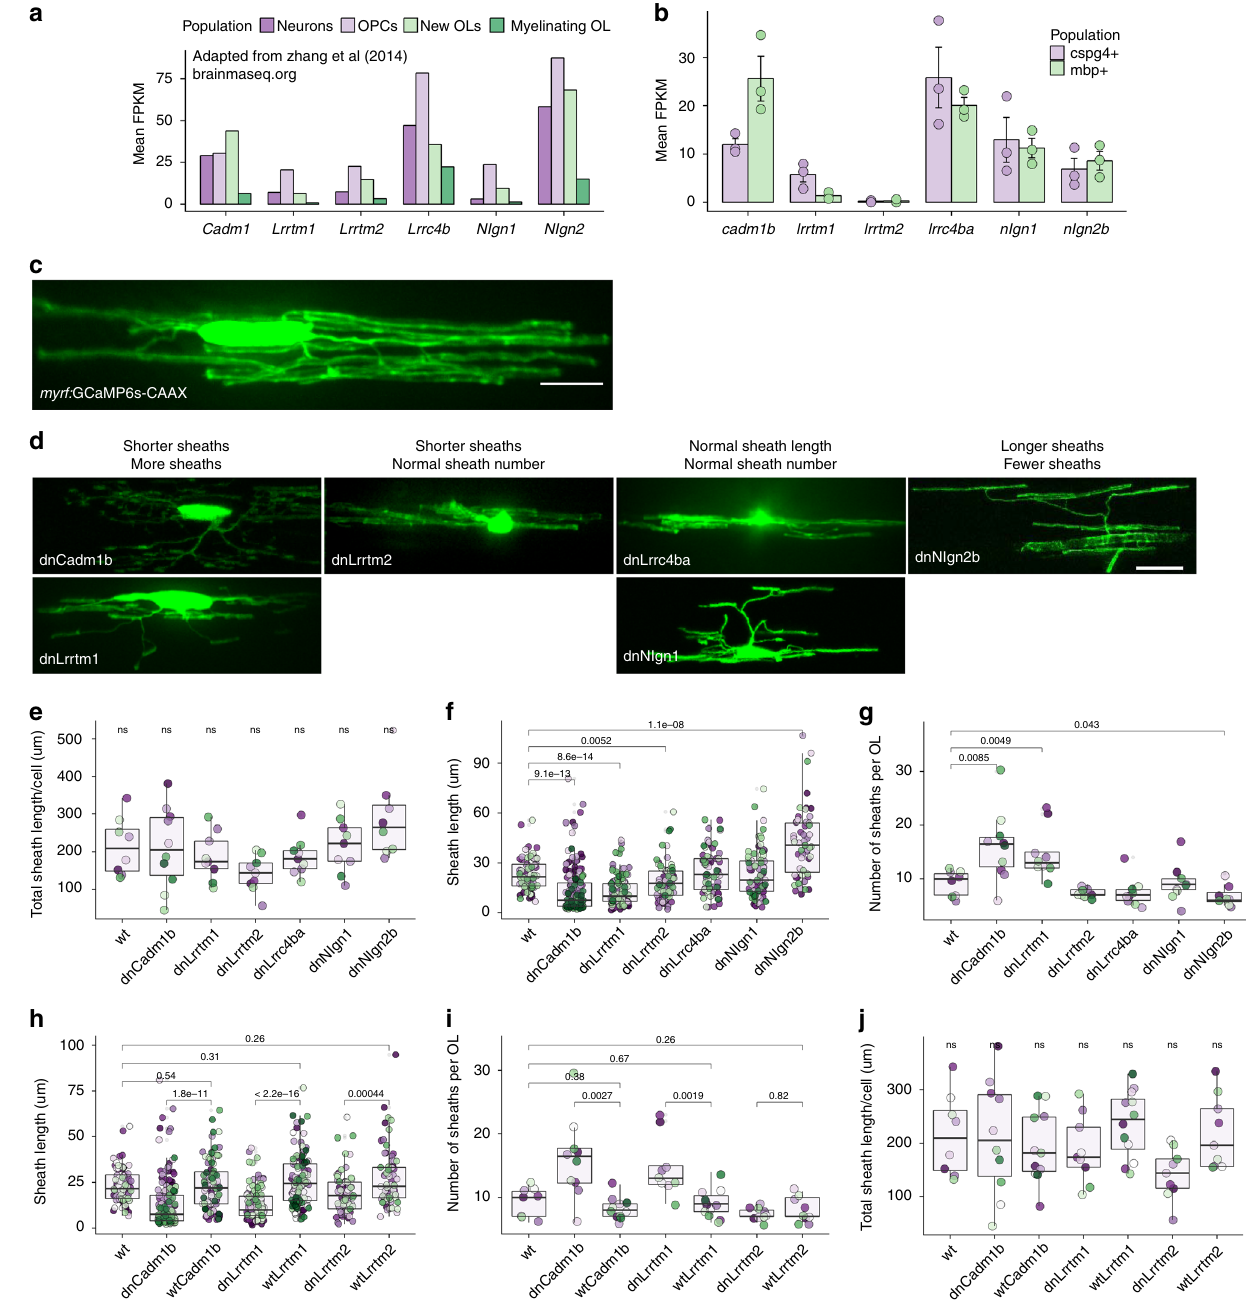
Fig. 4 Candidate synaptogenic adhesion molecules have variable effects on myelin sheath length and number. a RNA-seq FPKM values for mouse cortical neurons, OPCs, new oligodendrocytes, and myelinating oligodendrocytes for candidates Cadm1, Lrrtm1, Lrrtm2, Lrrc4b, Nlgn1, and Nlgn2. Plot generated using publicly available values from brainrnaseq.org 14 . b RNA-seq FPKM values for FAC-sorted zebra fi sh olig2 + / cspg4 + (cspg4 + ) and mbpa + / olig2 + (mbp + ) cells for zebra fi sh homologs of the same candidates 36 . c Oligodendrocyte transiently expressing myrf :GCaMP6s-CAAX. Scale bar 10 µ m. d Candidate dominant- negative (dn) alleles expressed transiently as myrf :dnX-2A-GCaMP6s-CAAX and grouped by effect on sheath length and number. Scale bar 10 µ m. e Total sheath length per cell expressing each dominant-negative candidate was unchanged by all candidates, Kruskal – Wallis test. Dot color marks individual cells and matches colored dots in corresponding sheath length and number plots. f Sheath length values for each dominant-negative candidate. n (cells/sheaths) = 8/74 wt, 10/159 dnCadm1b, 9/132 dnLrrtm1, 9/67 dnLrrtm2, 9/68 dnLrrc4ba, 9/83 dnNlgn1, 8/55 dnNlgn2b. Data in plots f – i were tested by Wilcox rank-sum with Bonferroni-Holm correction for multiple comparisons. dnLrrc4ba/wt and dnNlgn1/wt comparisons were ns. g Sheath number values for each dominant- negative candidate ( n listed in f ). h Decreased sheath length in dnCadm1b, dnLrrtm1, and dnLrrtm2 cells is speci fi c to the DN disruption, because expression of the full-length (wt) protein does not reduce sheath length. n (cells/sheaths) = 11/91 wtCadm1b, 12/108 wtLrrtm1, 9/72 wtLrrtm2. i Expression of WT forms of the three candidates that reduced sheath length resulted in normal sheath number. j Total sheath length per cell expressing each WT candidate was not signi fi cantly different for any group, Kruskal – Wallis